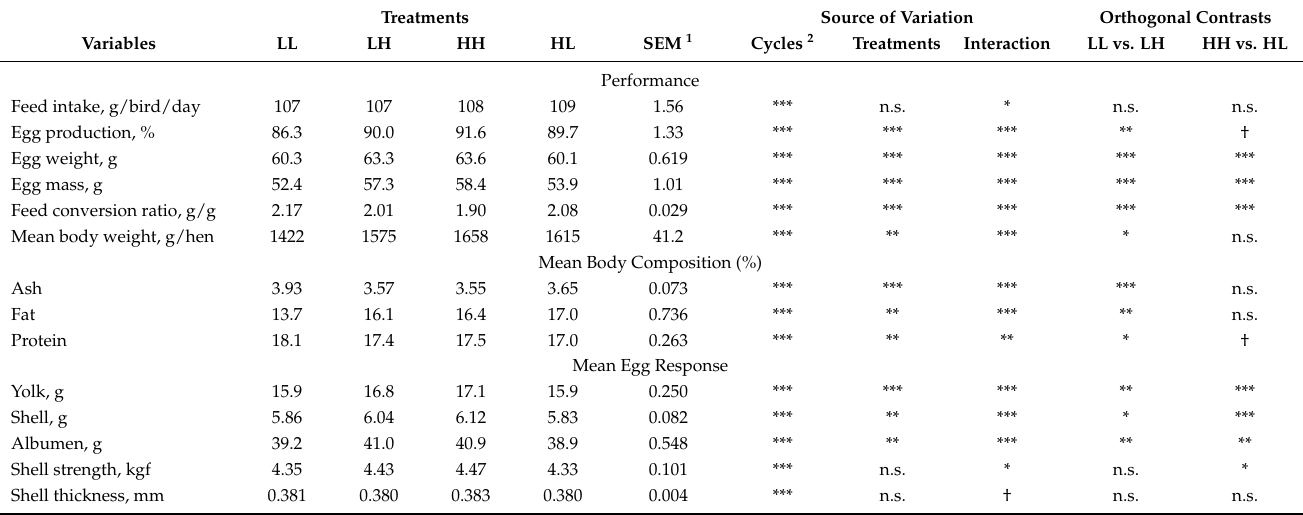
Table 5. Analysis of variance and contrasts for performance, body composition, and egg quality of laying hens from 19 to 102 weeks old in response to levels of dietary balanced protein (LL or HH), repleted (LH) and depleted feeds (HL).